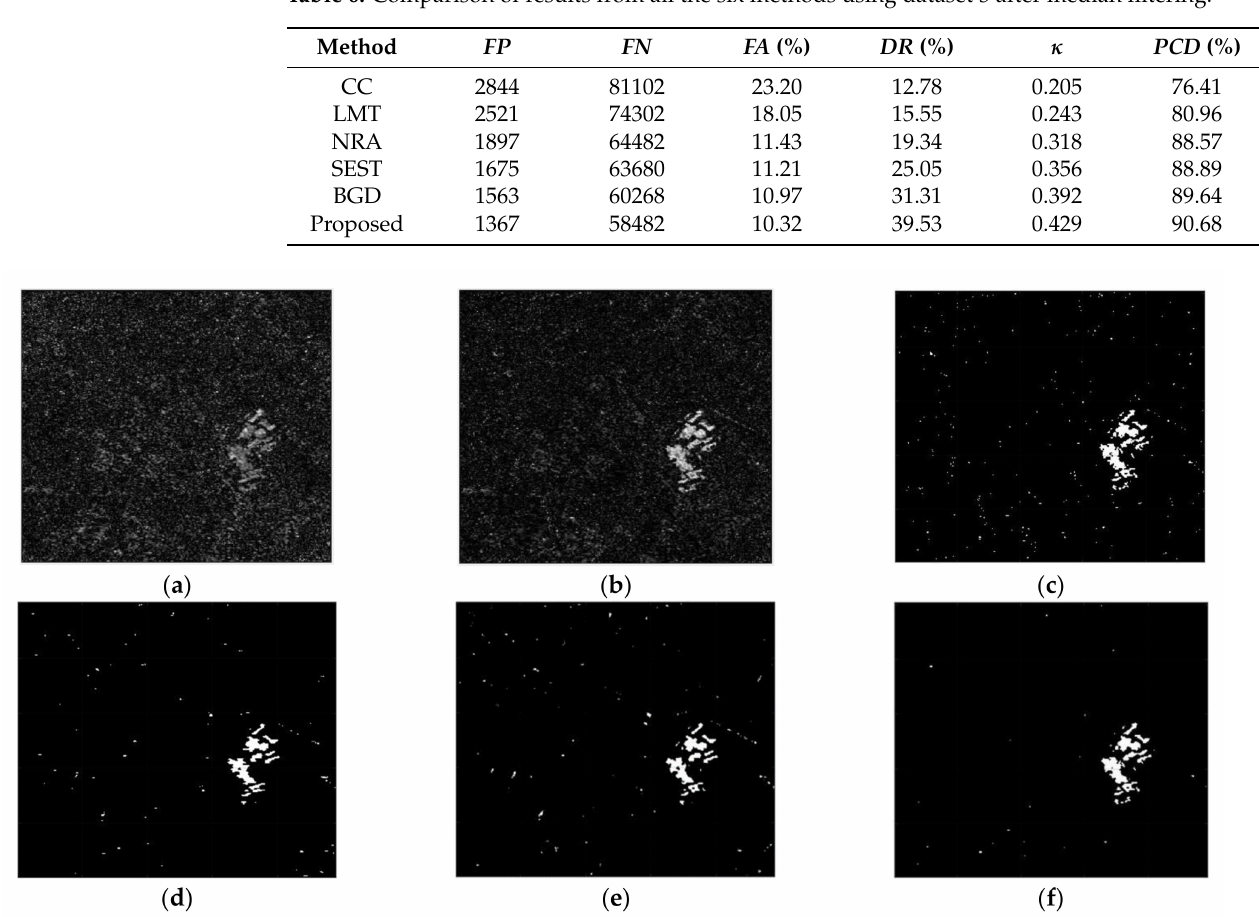
Figure 7. CDMs using dataset 1 obtained by six CD algorithms before median filtering in the post processing step. ( a ) CDM reconstructed by the CC. ( b ) CDM reconstructed by the LMT. ( c ) CDM reconstructed by the NRA. ( d ) CDM reconstructed by the SEST. ( e ) CDM reconstructed by the BGD. ( f ) CDM reconstructed by the proposed method.